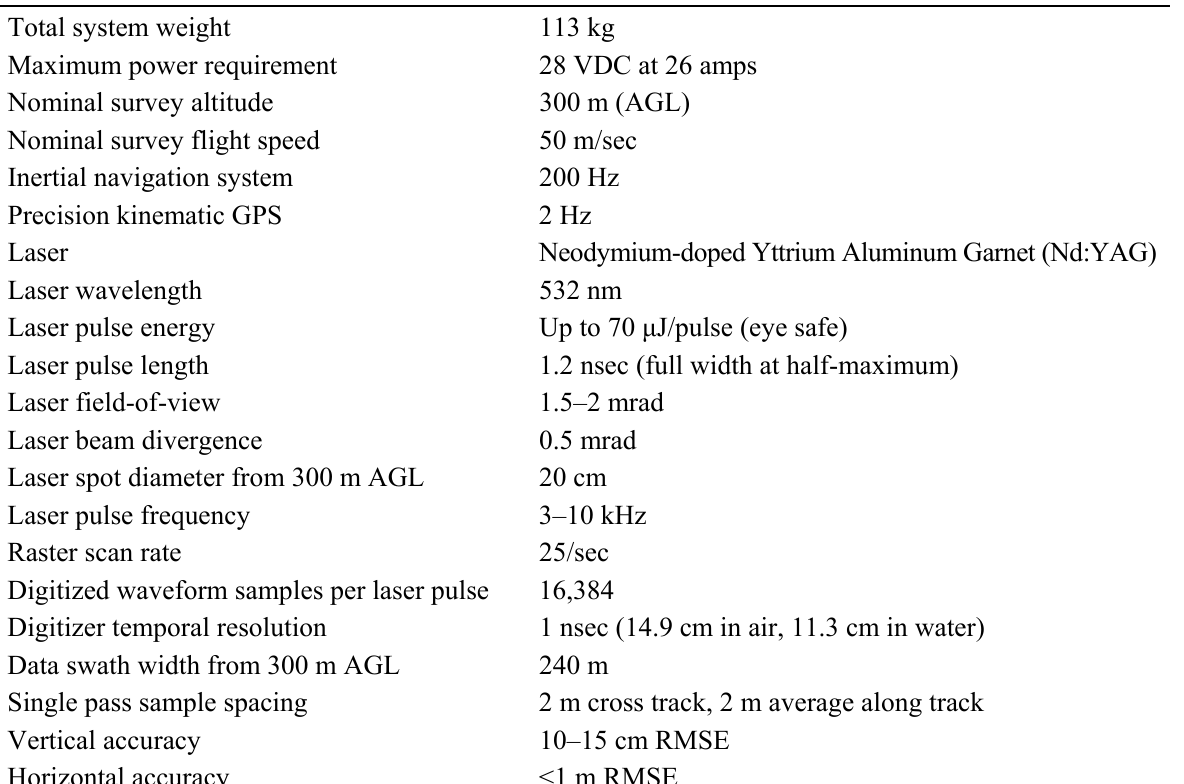
Table 1. EAARL Technical Specifications